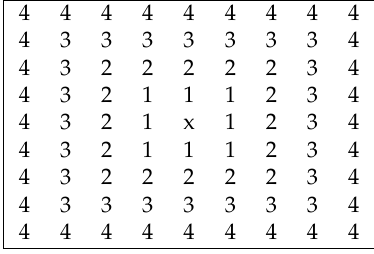
Figure 5. Representation of the baselines between SAIs relative to the central view (x), giving the order in which the final disparity map is to be filled in, starting from the largest